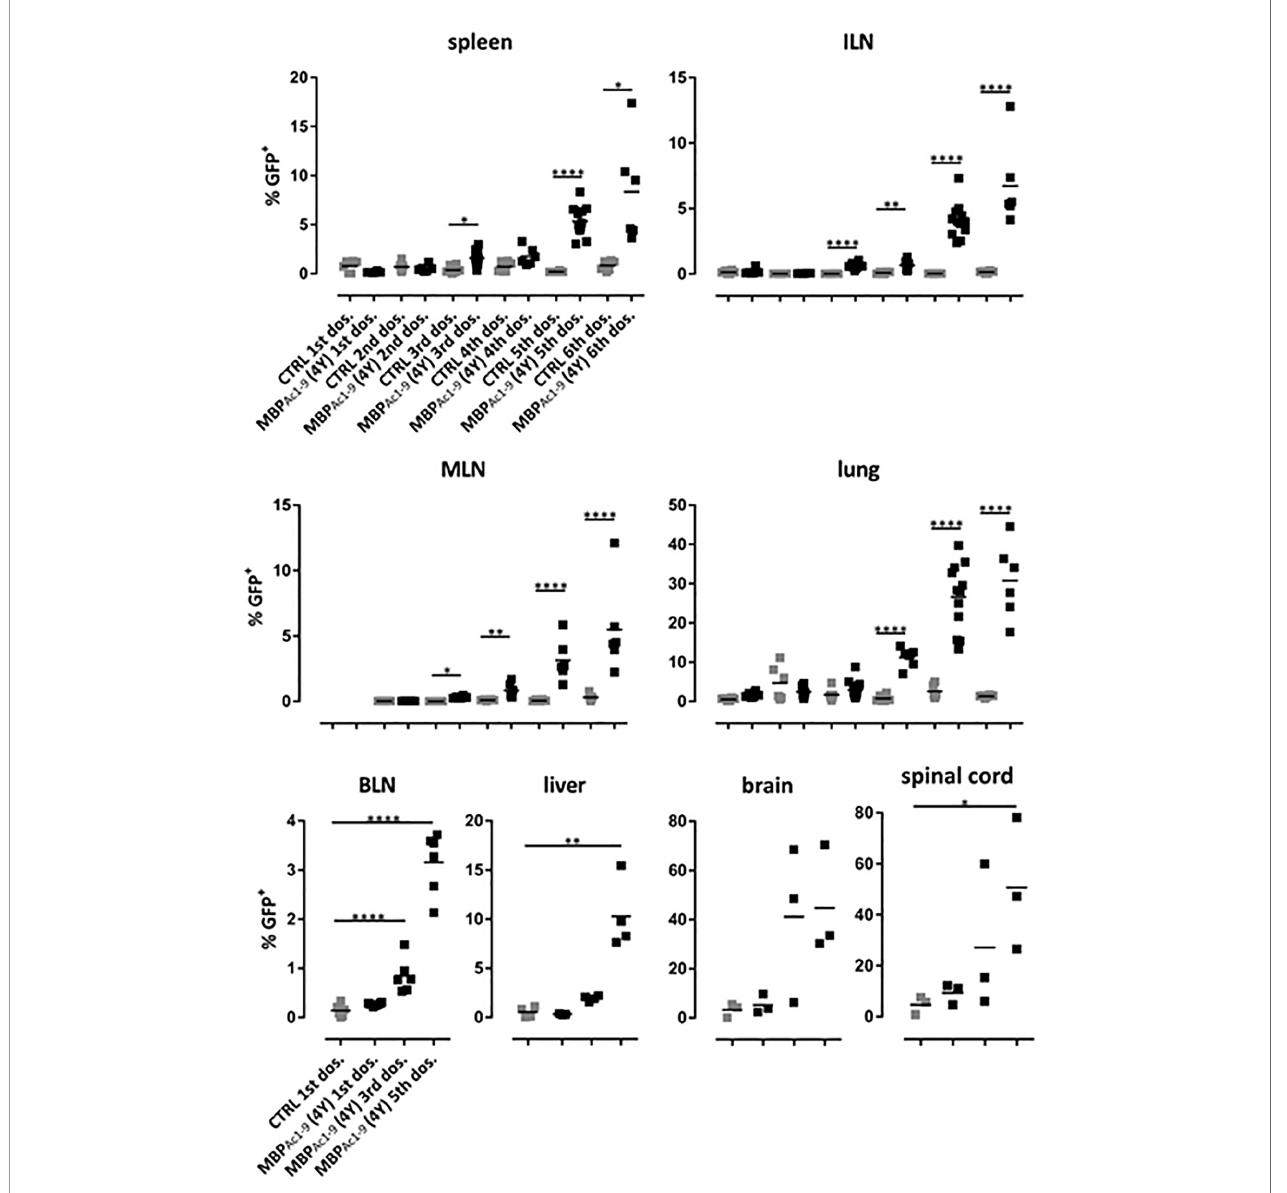
FIGURE 6 | Distribution of IL-10 producing CD4 + T cells during the course of tolerization. tiger-Tg4 mice were treated with 4Y peptide by dose escalation as shown in Figure 3E . Two hours after the indicated dose animals were perfused with PBS and organs were isolated. After gating on viable, single CD4 + T cells, IL-10 + T cells were investigated by fl ow cytometry. Horizontal lines indicate the mean (*p ≤ 0.05, **p ≤ 0.01, ***p ≤ 0.001, ****p ≤ 0.0001). In the spleen, ILN (inguinal lymph nodes), MLN (mediastinal LN), lung and BLN (brachial LN) each dot represents one individual. In the liver, in some cases cells from two animals were combined due to low cell numbers while in the CNS compartment each dot represents two